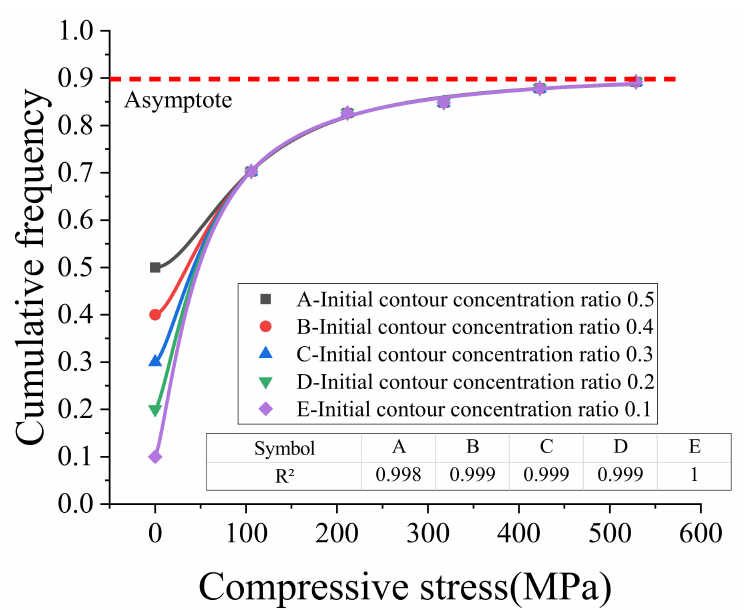
Figure 15. Regression curve of contour distribution near the support center.